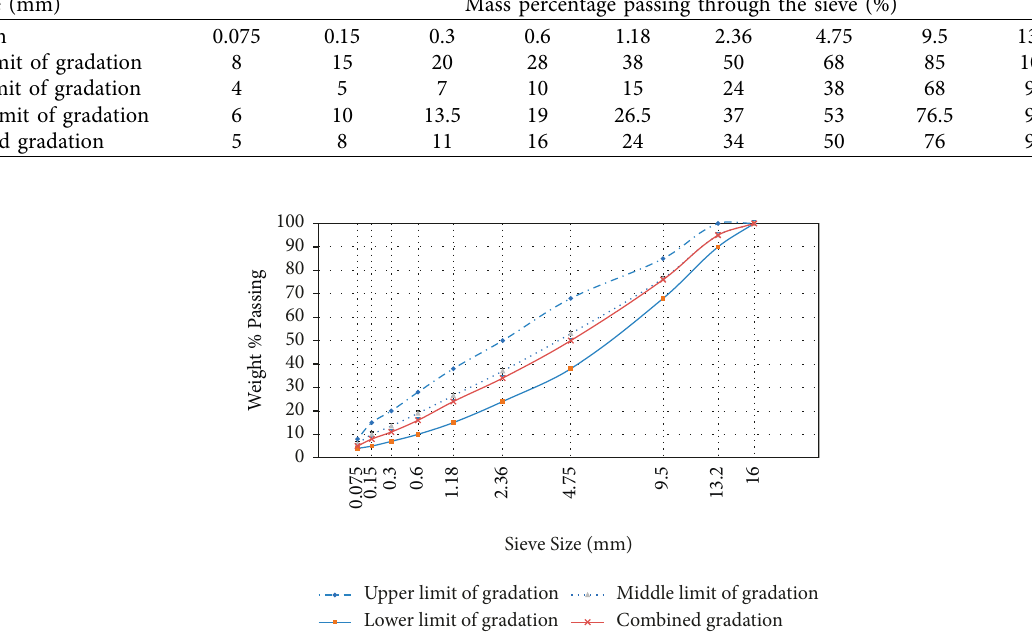
Figure 2: Aggregate gradation